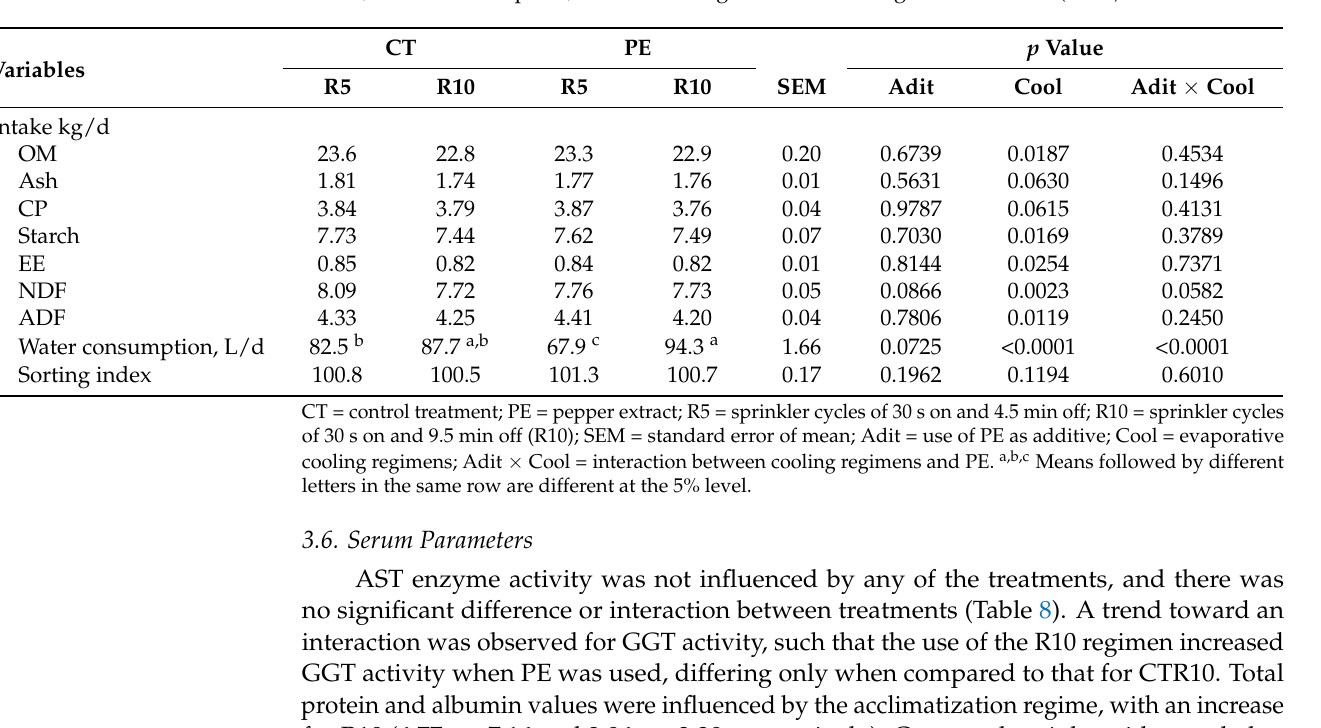
Table 7. Effects of different evaporative cooling regimens and the use or absence of PE on nutrient intake, water consumption, and the sorting index of lactating Holstein cows ( n = 8).